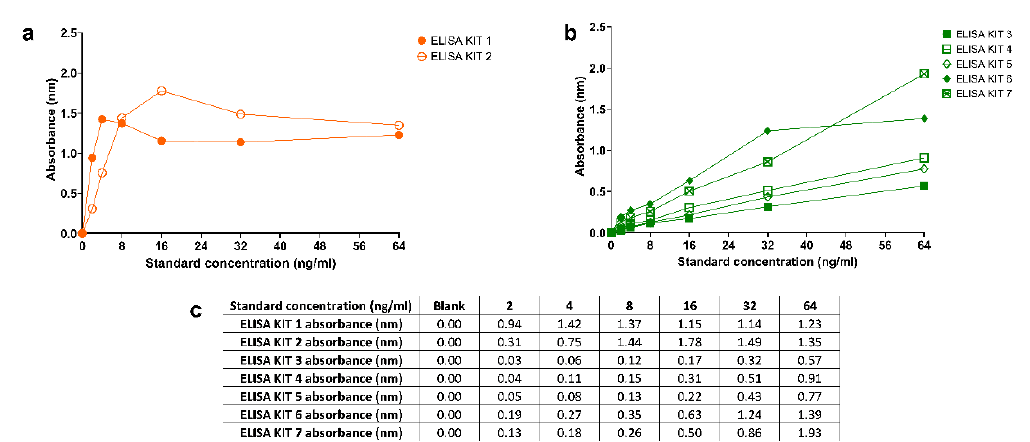
Figure 2: a. Graphs of absorbance values for the original BT Human TMAO ELISA kit protocol. b. Graphs of absorbance values for the modified BT Human TMAO ELISA kit protocol. c. Mean absorb- ance values corresponding to each standard